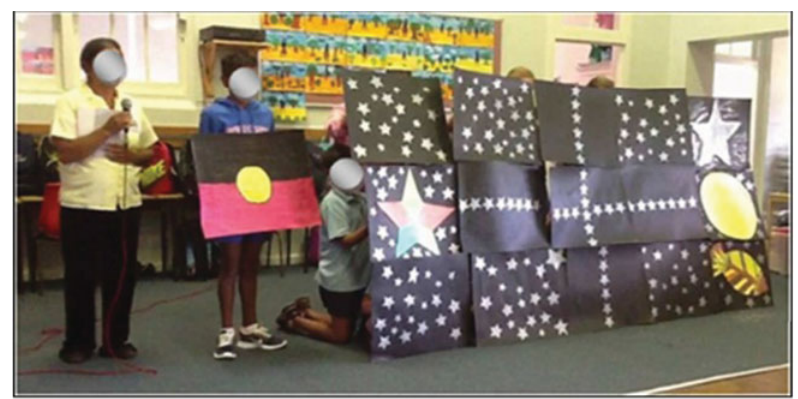
(Colour online) Screen shot from sky storytelling event